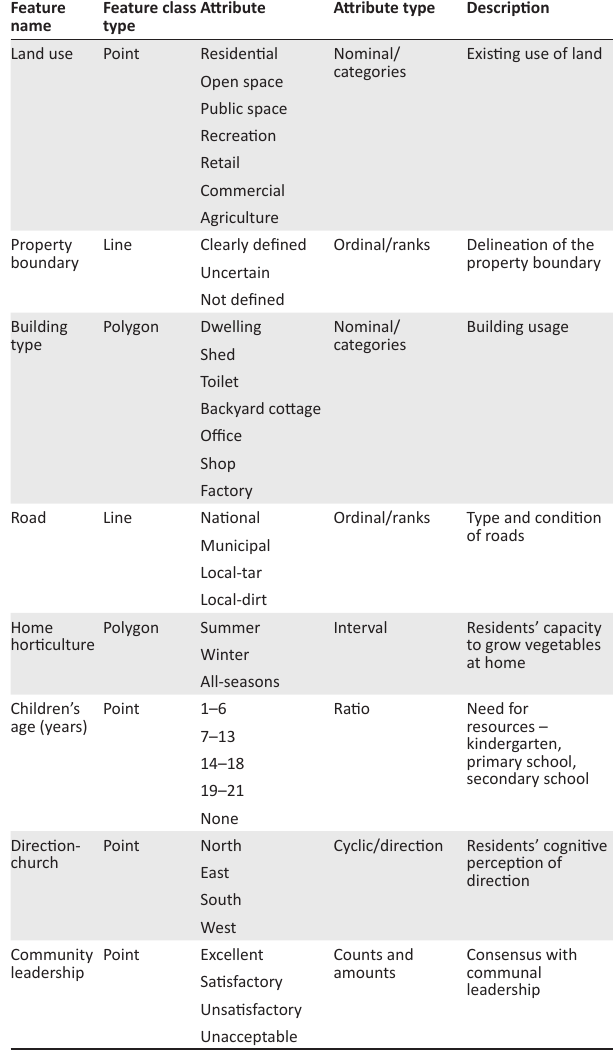
TABLE 1: Data dictionary for data